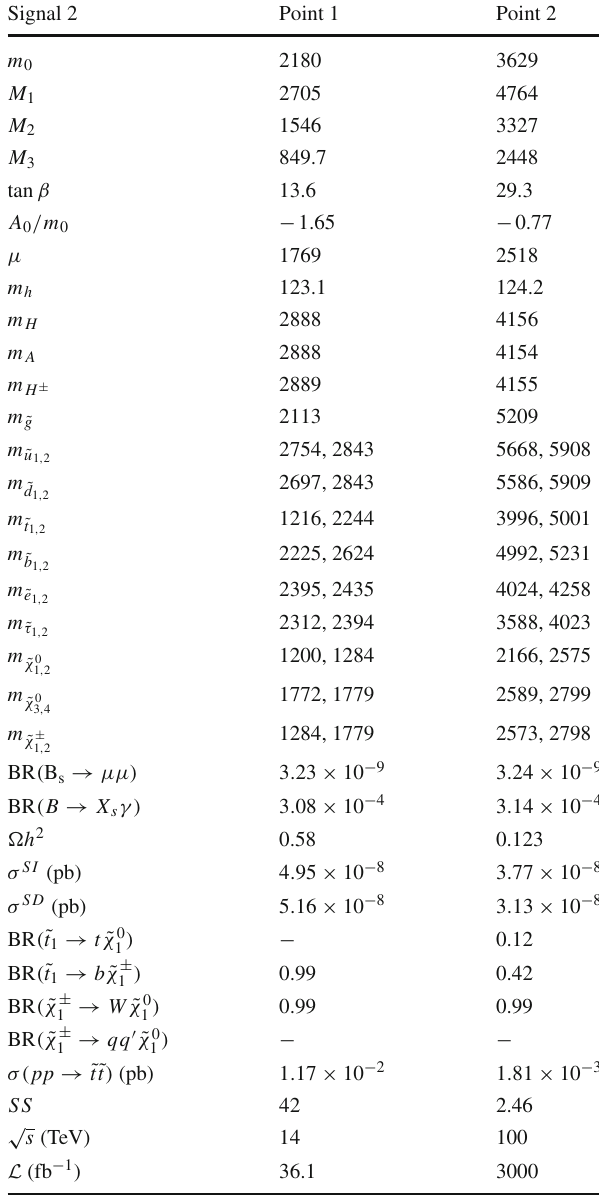
Table2 Benchmarkpointsfor68%and95%CLprobeofstopsthrough Signal 2. Point selection is the same as explained in Table 1 Signal